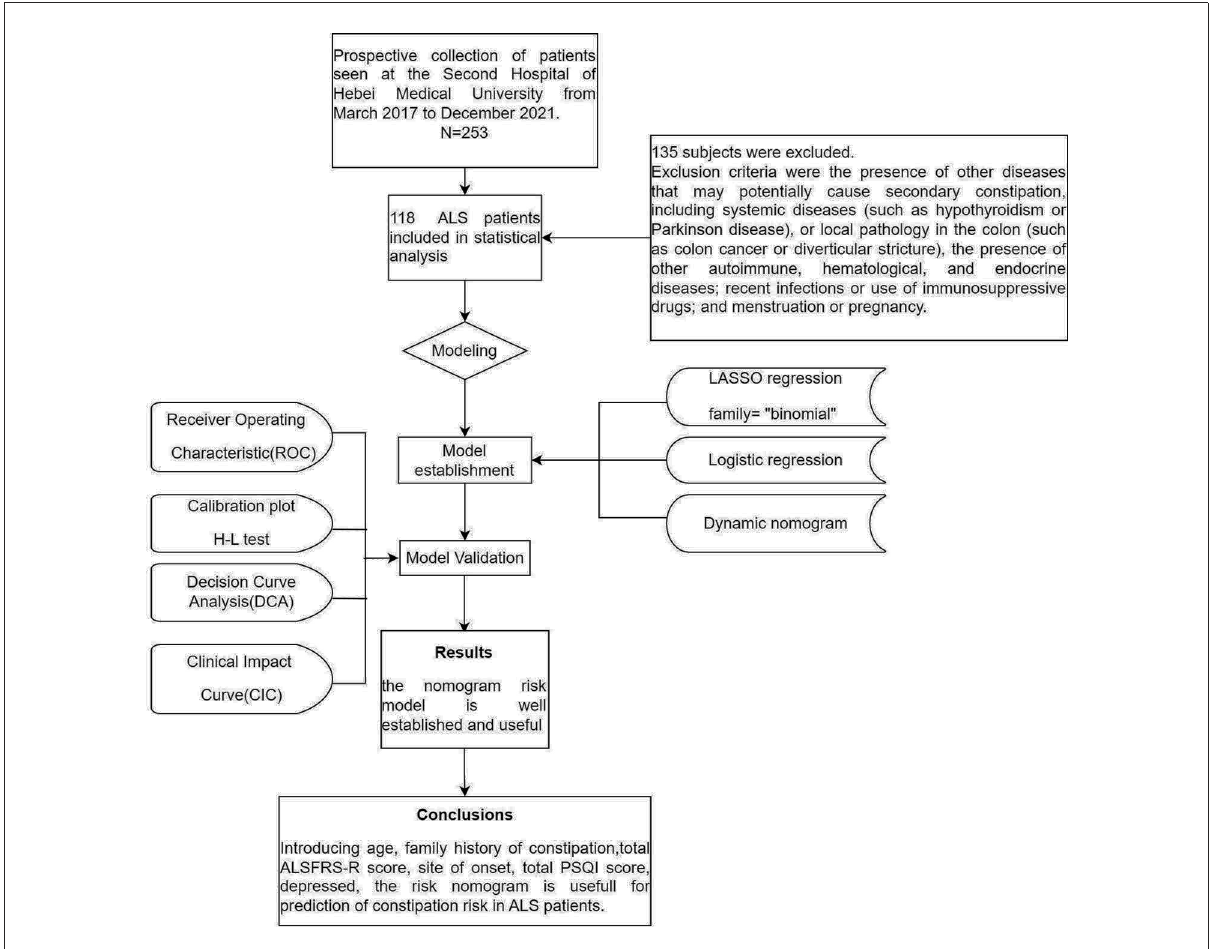
FIGURE1 Flow diagram of study